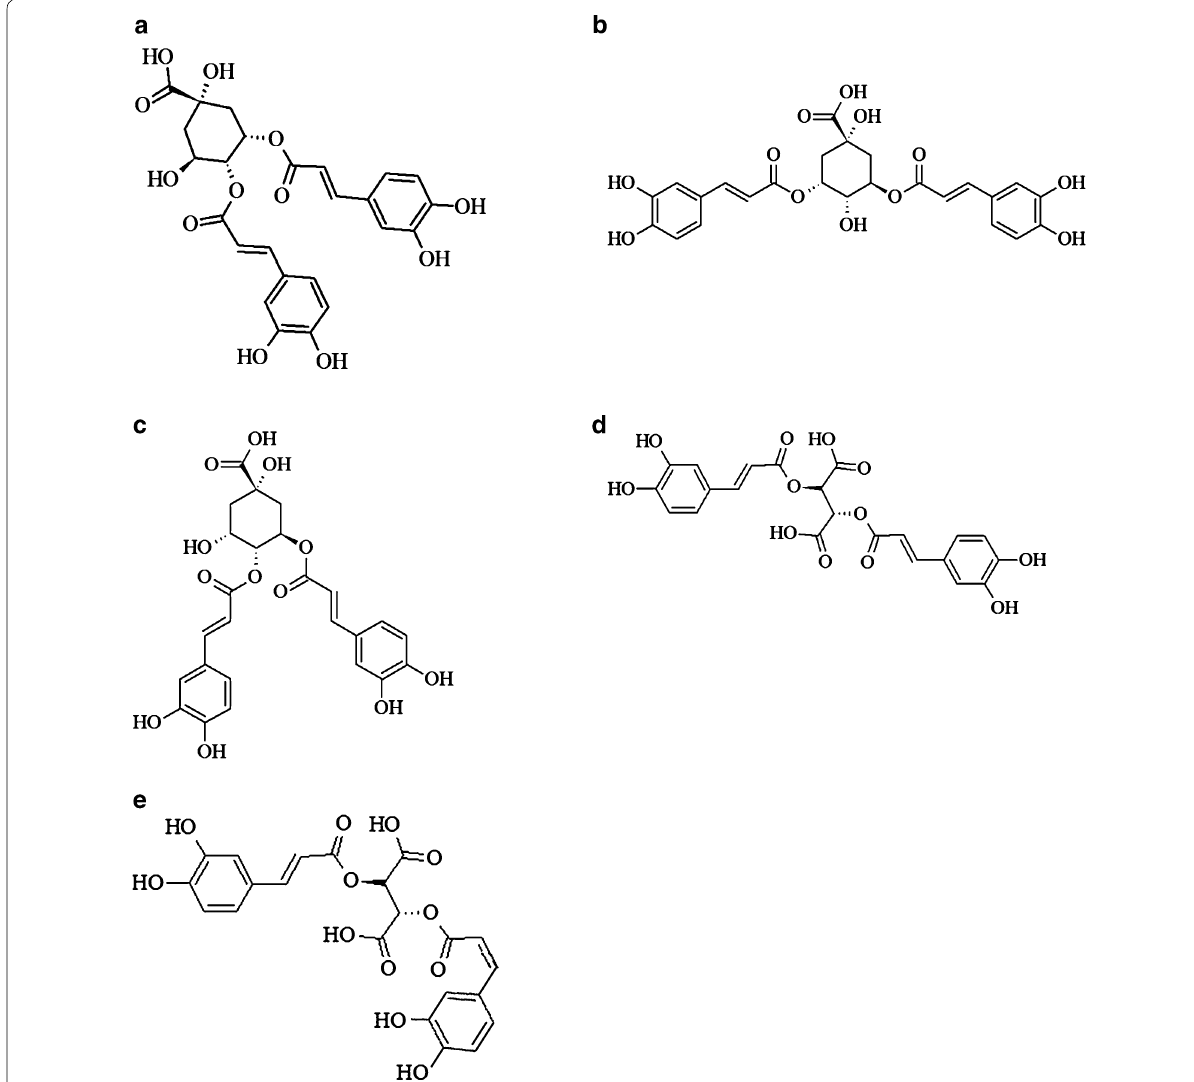
Fig. 2 Molecular structures of 3,4 diCQA ( a ), 3,5 diCQA ( b ), 4,5 diCQA ( c ), CA ( d ) and CA isomer ( e